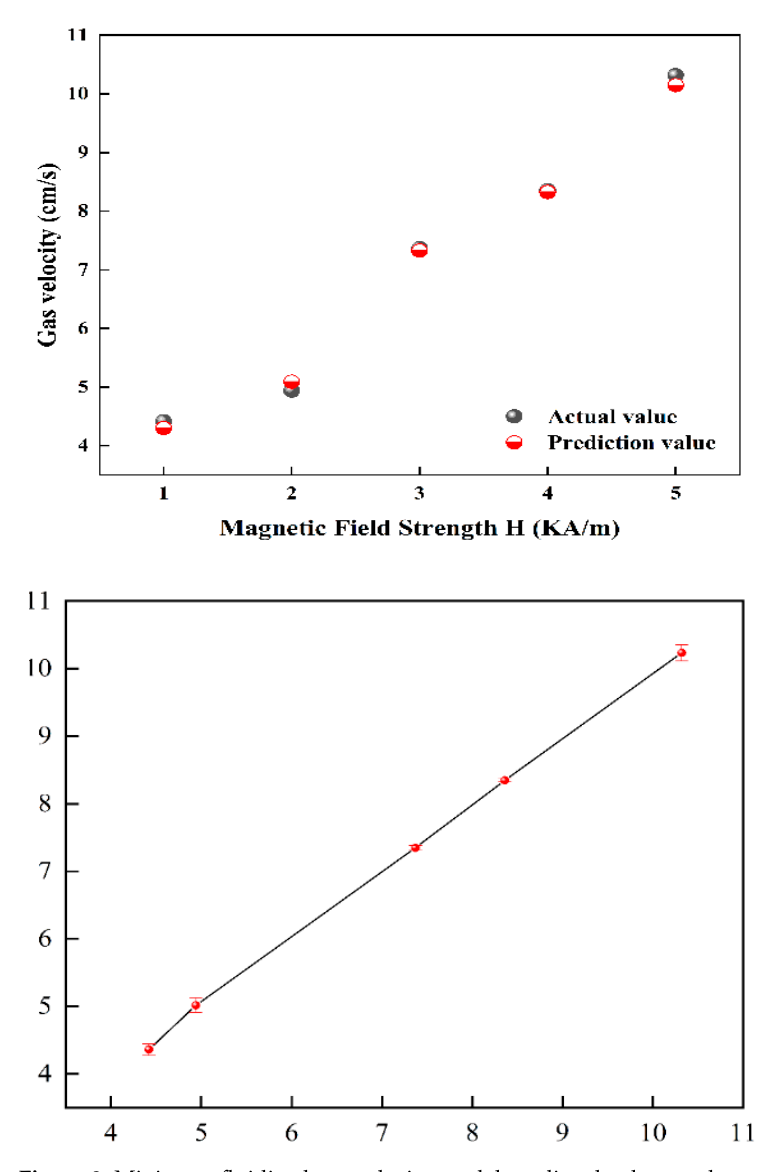
Figure 8. Minimum fluidized gas velocity model predicted values and error bars.